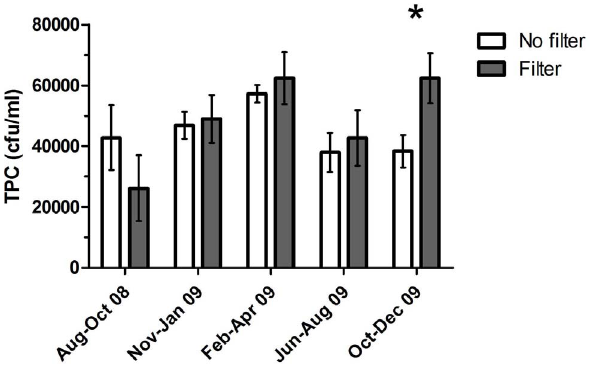
Fig. 5. TPC in filtrated versus non-filtrated shower water of Nursing Home 1. The water was filtrated through a membrane filter (0.02 m m) placed in the water flow upstream of the shower rooms in one of three building wings. The * indicates the only sampling point with a statistical difference between filtrated and non- filtrated water (t-test, P , 0.05, both parametrically and